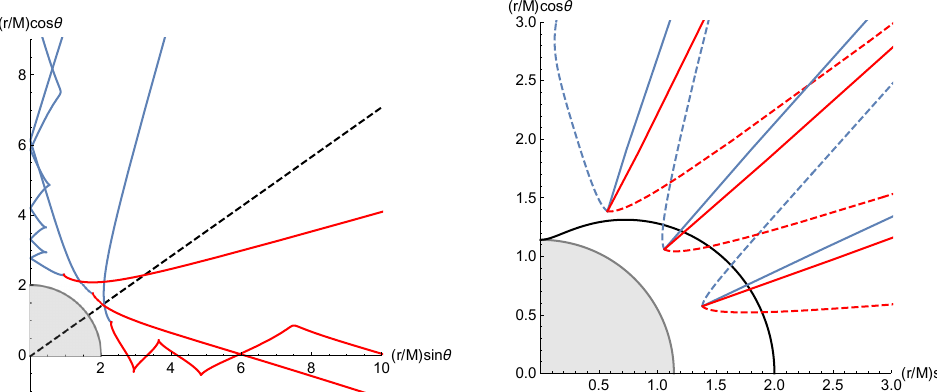
Figure 4. Examples of trajectories in the ( r , θ ) plane. The trajectory of the positively charged particles is shown by the blue curve, whereas that of negatively charged particle is shown by the red curve. The left panel shows the results for | κ | = 10 3 in Schwarzschild spacetime. The initial positions are ( r 0 , θ 0 ) =( 2.5 M, π /8 ) , ( 2.5 M, π /4 ) , and ( 2.5 M, 3 π /8 ) . The black dotted line represents cos θ = 3 − 1/2 . The right panel shows results for | κ | = 10 6 (dotted curve) and 10 9 (solid curve) in the Kerr spacetime with a = 0.99 M. The initial positions are ( r 0 , θ 0 ) =( 1.5 M, π /8 ) , ( 1.5 M, π /4 ) , and ( 1.5 M, 3 π /8 ) . The evolution of the Lorentz factor for these parameters are shown in the bottom panels in Figure 3. The horizon and ergo-region are shown by the black